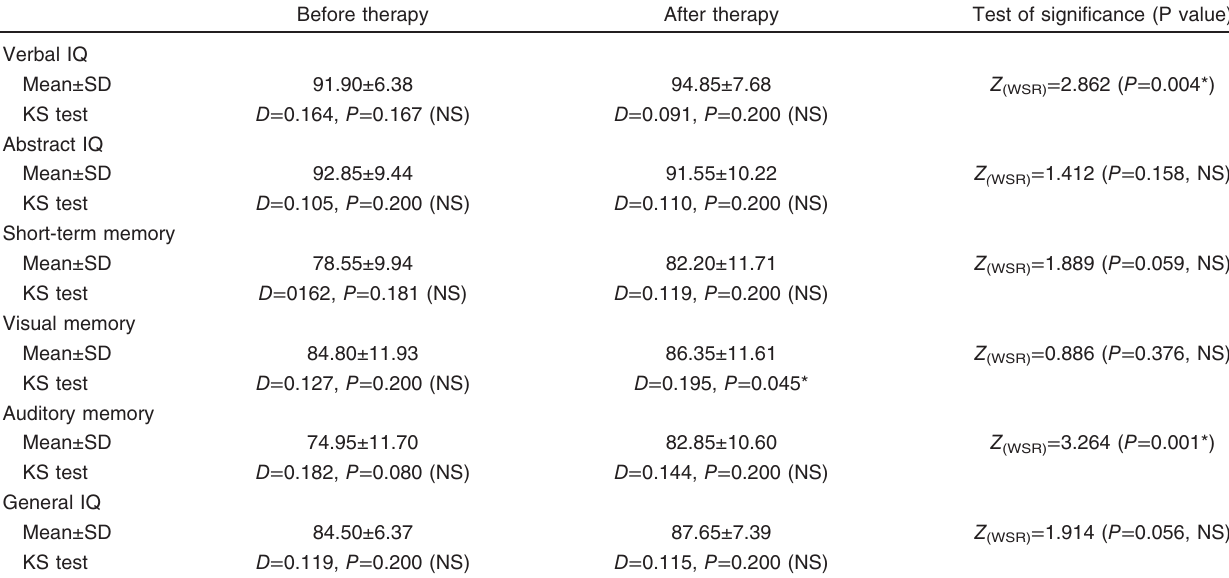
Table 2 Results of the Stanford Binet Scale before and after therapy Before